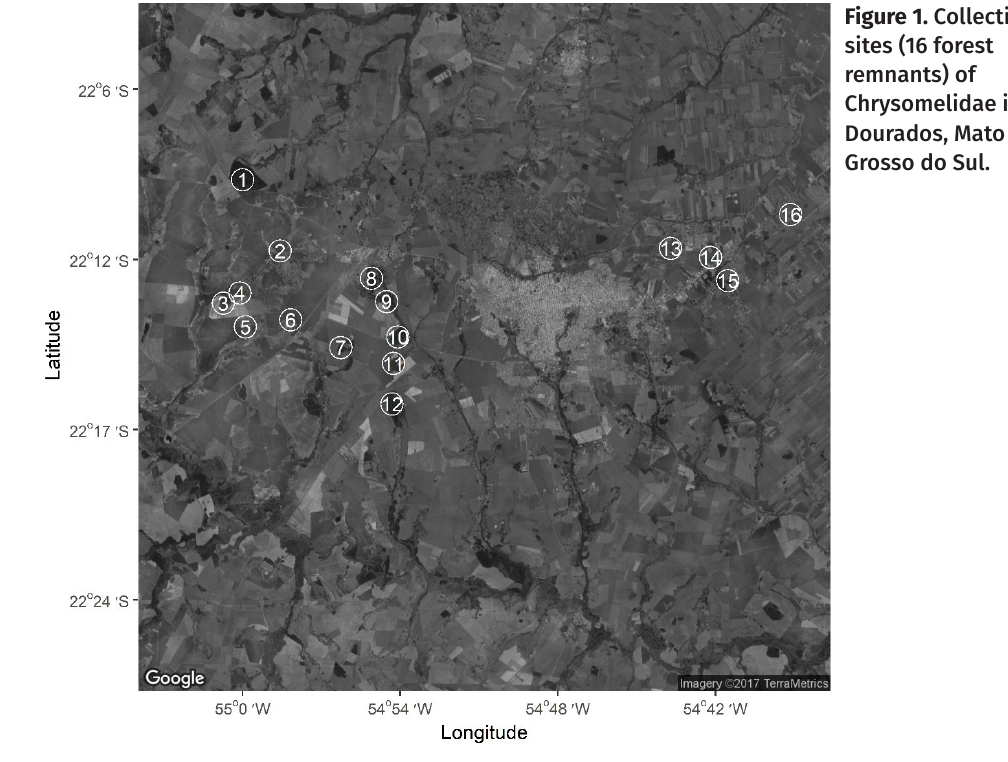
Figure 1. Collection sites (16 forest remnants) of Chrysomelidae in Dourados, Mato Grosso do